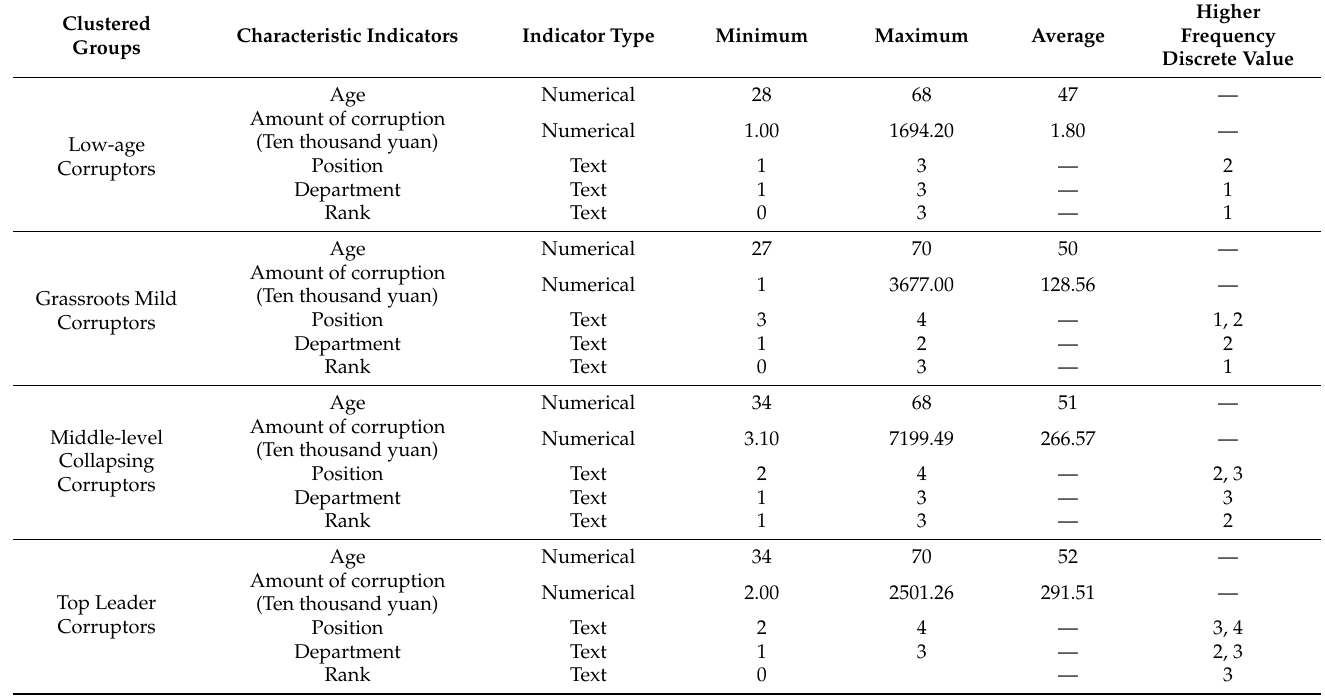
Table 4. Results of corruptors’ subjective characteristics.